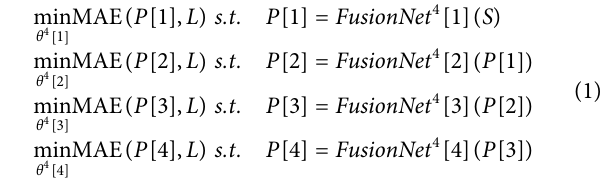
TABLE 3 | Segmentation accuracy on a test volume from the zebra fi sh EM dataset. Bold values correspond to the method presented here. Methods FusionNetW 2